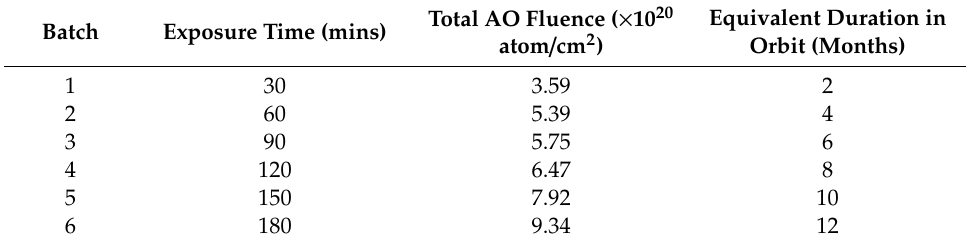
Table 3. Batches of samples tested under atomic oxygen (AO) fluence for each exposure. Total AO Fluence ( × 10 Batch Exposure Time (mins)